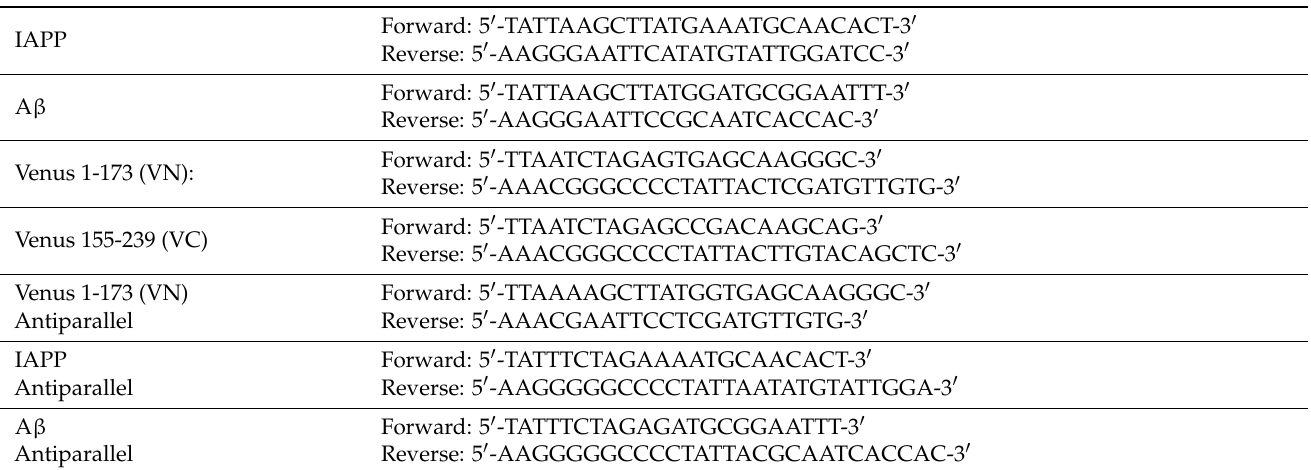
Table 1. PCR primers used for BiFC